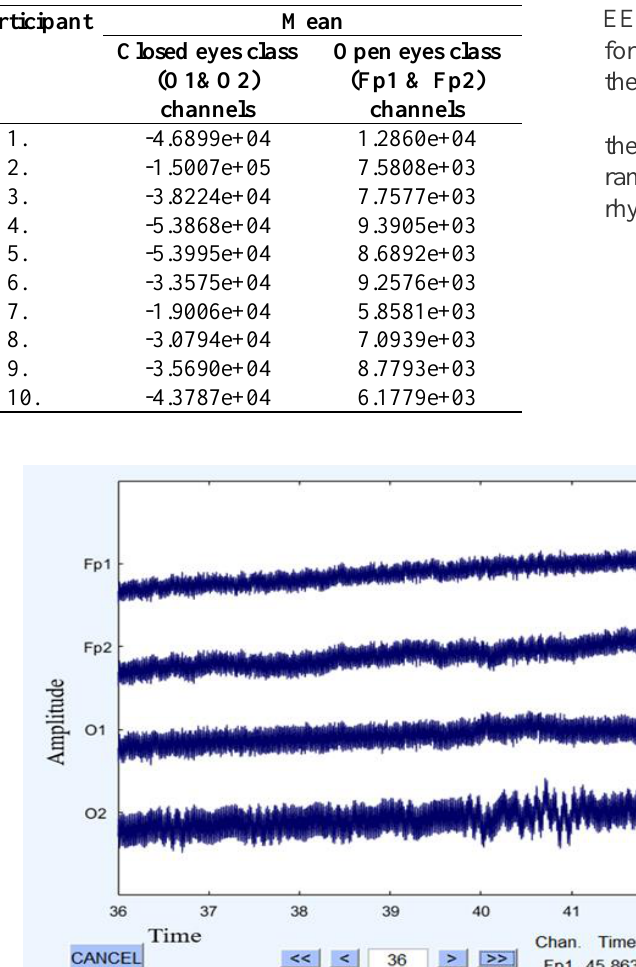
Fig. 6. The mean and standard deviation of frontal and occipital channels only. Table 3, The mean values for the frontal and occipital regions’ channels